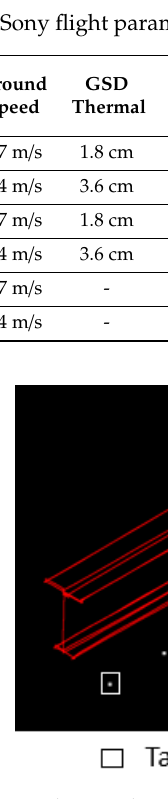
Table 3. FLIR and Sony flight parameters for the different data acquisition dates.